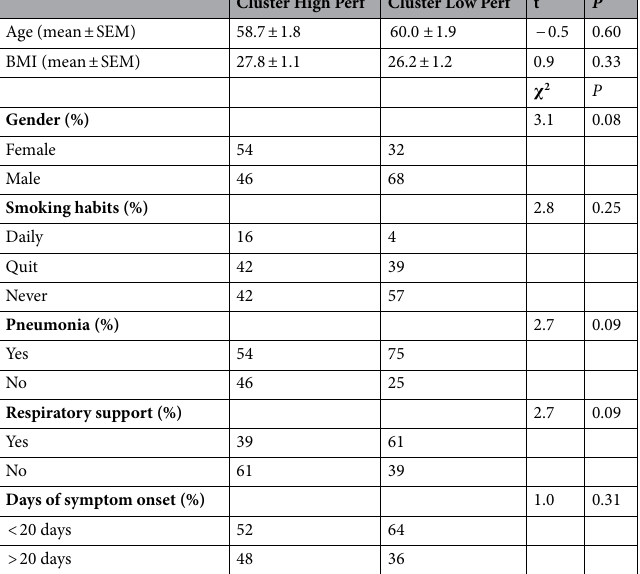
Table 3. Clusters’